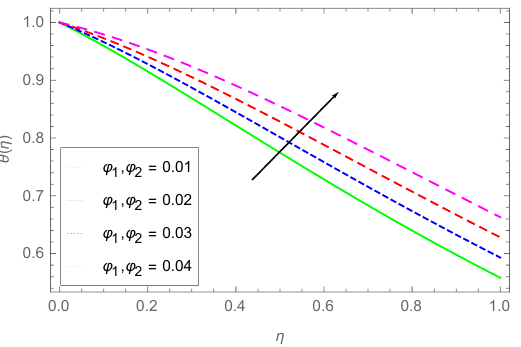
Figure 10. θ ( η ) dependence on nanomaterials’ concentration ϕ 1 , ϕ 2 . The variation of the fluid’s temperature θ with enhancing values of the unsteadiness parameter A 0 is displayed in Figure 11. The figure shows that the increasing A 0 results in an enhancement in the fluid’s temperature. The rate of enhancement with the rising A 0 remains almost constant as is clear from the equal separation between different curves. The different curves becomes almost parallel at the highest η . Furthermore, at fixed A 0 , the fluid’s temperature drops as we move away from the hot plate.